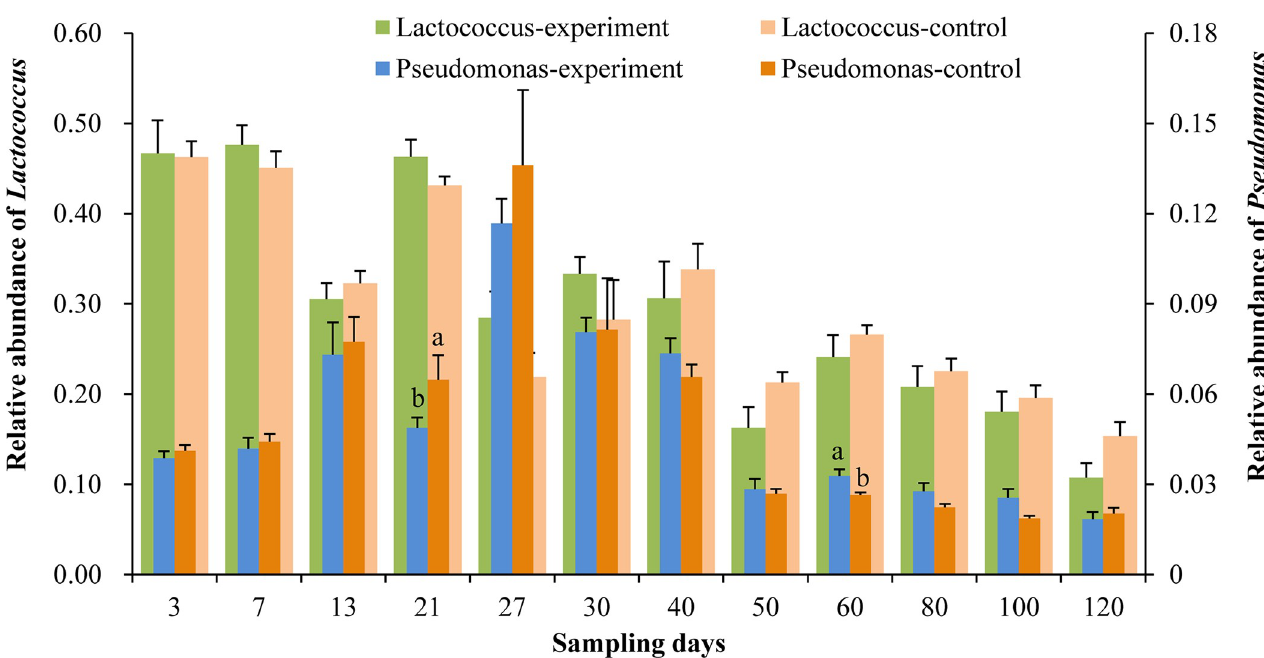
Fig 7. Relative abundances of Lactococcus and Pseudomonas spp. in the intestines of turbot larvae. For each sample, the averages were obtained based on five replicates. Values with different letters were significantly different on the same day ( P <